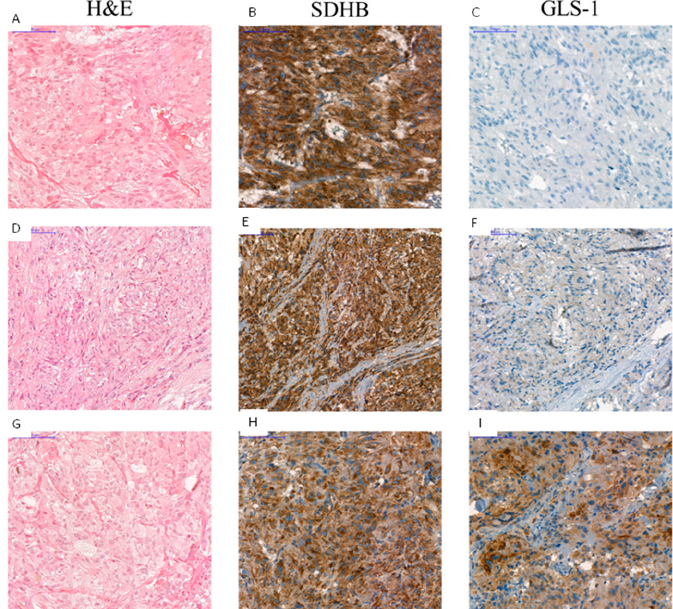
Figure 6. Immunohistochemistry: Immunostaining with antibodies against SDHB and GLS-1 of a paraganglioma associated with SDHB p. mutation ( A – C ) and a RET p.C634W-associated pheochromocytoma ( D – F ). Lack of SDHB staining in SDHB mutated tumors ( B ) and strong GLS-1 signal was detected in malignant SDHB -associated tumor ( C ). Lack of GLS-1 positive cells can be observed in RET -associated benign pheochromocytoma ( F ). Scale bar = 200 µm. H&E: hematoxylin and eosin staining. SDHB: succinate dehydrogenase subunit B staining. GLS-1: glutaminase-1 staining.